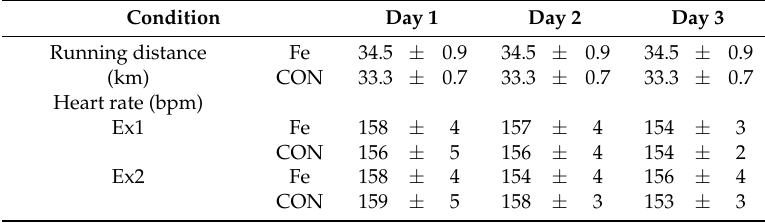
Table 1. Running distances and HR during training period.